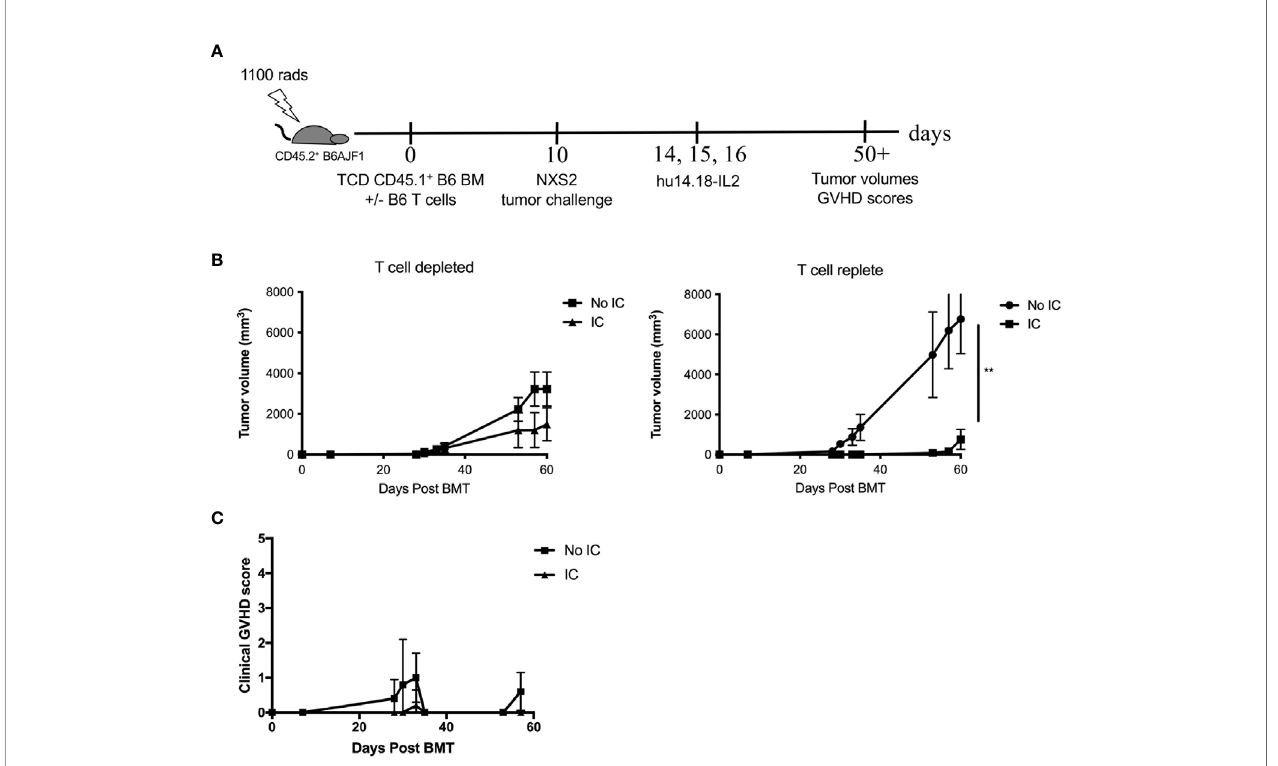
FIGURE 2 | GD2 + NXS2 neuroblastoma growth after allogeneic HSCT and hu14.18-IL2. (A) Lethally irradiated CD45.2 + B6AJF1 mice (H-2 b x a ) were transplanted with either CD3e cell depleted (T cell depleted) or CD3e depleted BM replenished with 2.5 x 10 3 T cells (T cell replete) from congenic CD45.1 + B6 mice (H-2 b ) on Day +0. On Day +10, 2 x 10 6 NXS2 tumor cells were inoculated into the right fl ank. On days +14-16, PBS (No IC) or hu14.18-IL-2 (IC) was administered and (B) tumor growth was monitored by using a digital caliper as well as (C) clinical GVHD scores. N=5 mice/group. ** p =